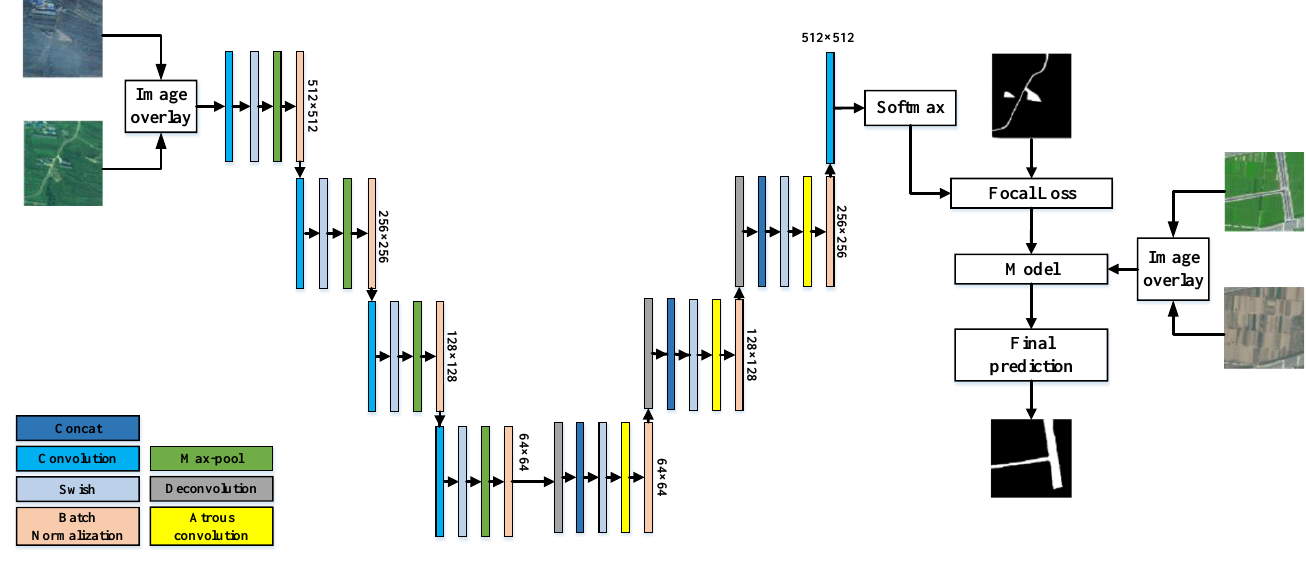
Figure 2. Network